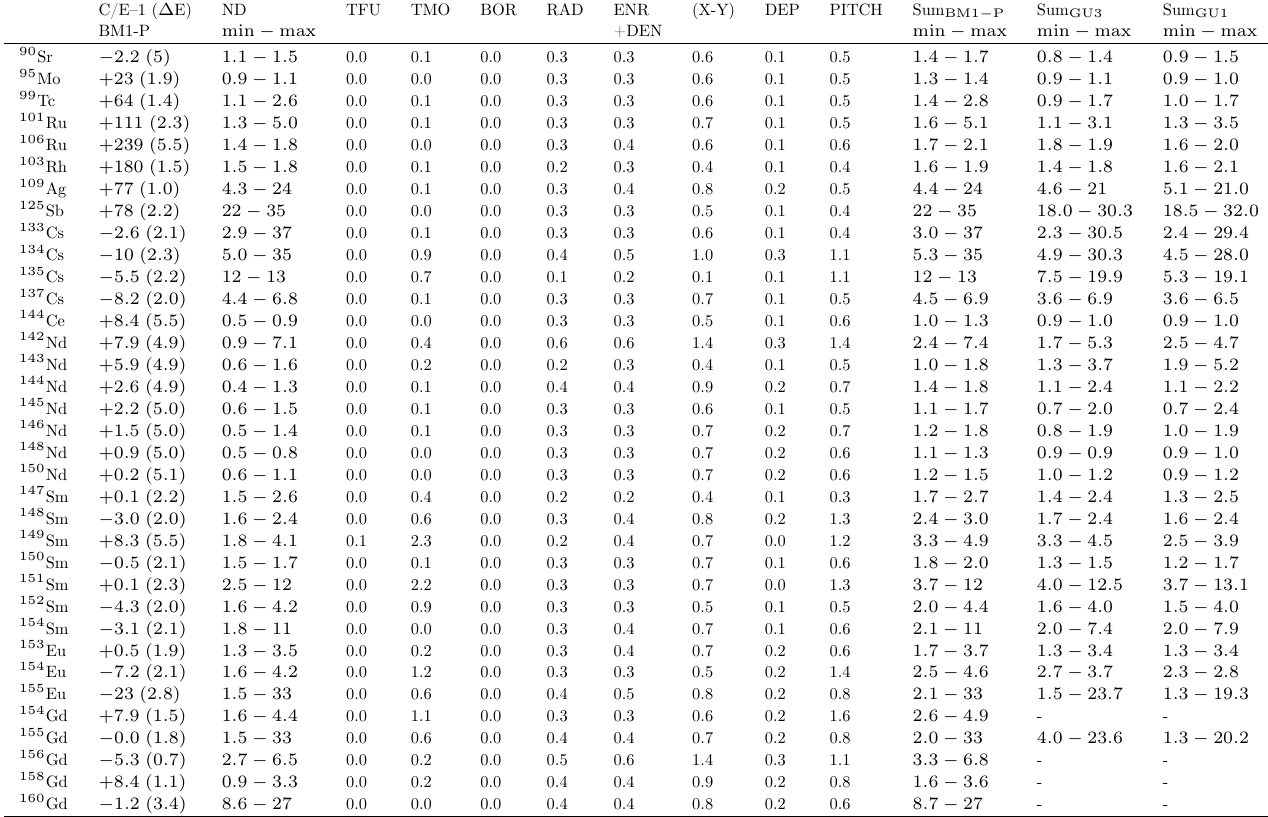
Table B.10. Same as Table B.9, but for fission